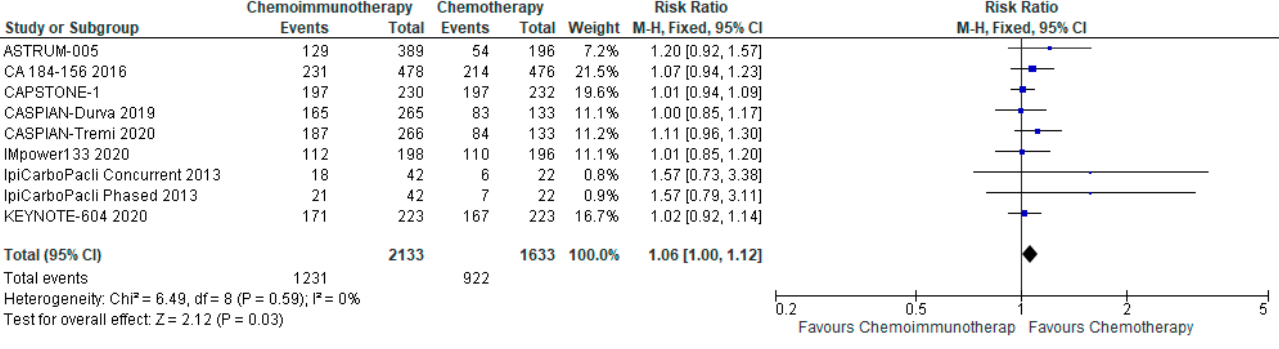
Figure 6. Forest plot of risk ratios for Grade 3–4 adverse events in patients with ES-SCLC and treated with chemo-ICI versus standard chemotherapy. PD-1/PD-L1, programmed death (ligand) -1; CTLA- 4, cytotoxic T-lymphocyte-associated protein 4; HR, hazard ratio; CI, confidence interval; M-H, Mantel-Haenszel.